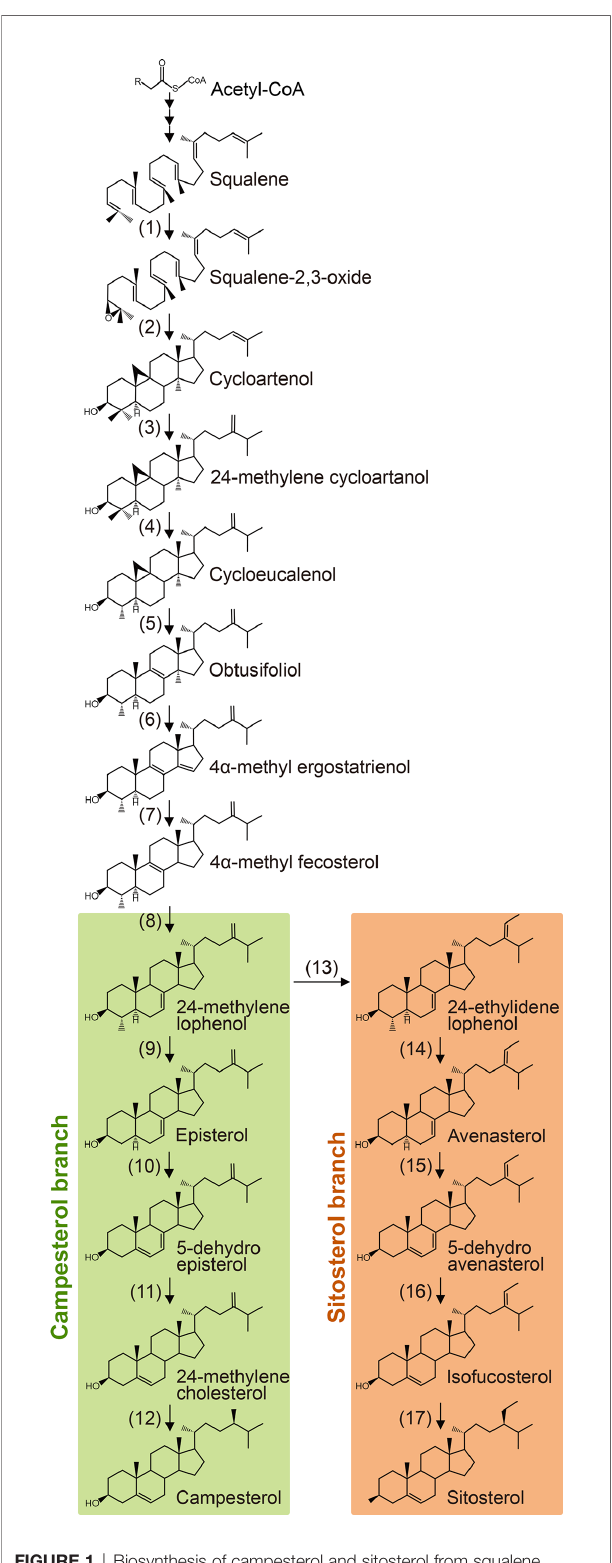
FIGURE 1 | Biosynthesis of campesterol and sitosterol from squalene. Numbers correspond to the description in the text and Table 1 . Enzymes identi fi ed from higher plants are listed in Table 1